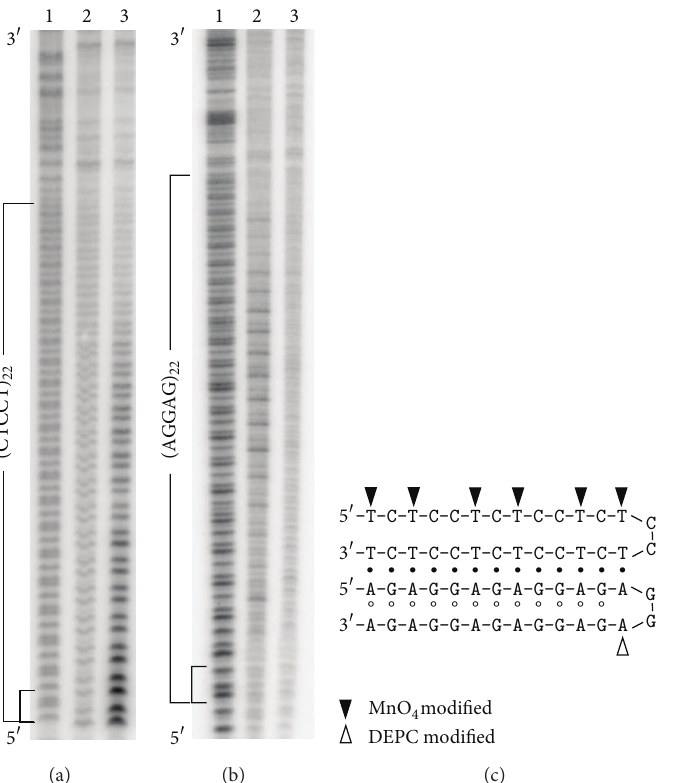
Figure 4: Supercoiling-induced structural change in the AGGAG repeat detected by chemical modification. Reactions of the Maxam- Gilbert type were carried out on relaxed and supercoiled pSK-(AGGAG) 22 and analyzed by sequencing gel. (a) Oxidation of T residues by permanganate. Lane 1: Maxam-Gilbert C reaction; lane 2: relaxed DNA; lane 3: supercoiled DNA. The large bracket indicates the repeat and the small one, the 5 󸀠 -most CTCCT unit. (b) Modification of A residues by diethylpyrocarbonate. Lane 1: Maxam-Gilbert G reaction; lane 2: supercoiled DNA; lane 3: relaxed DNA. The large bracket indicates the repeat and the small one, the 5 󸀠 -most AGGAG unit. (c) An H-r3 structure consistent with the modification results. Filled circles indicate Watson-Crick base pairing, and open circles indicate triplex formation. Triangles indicate the bases expected to be reactive to the